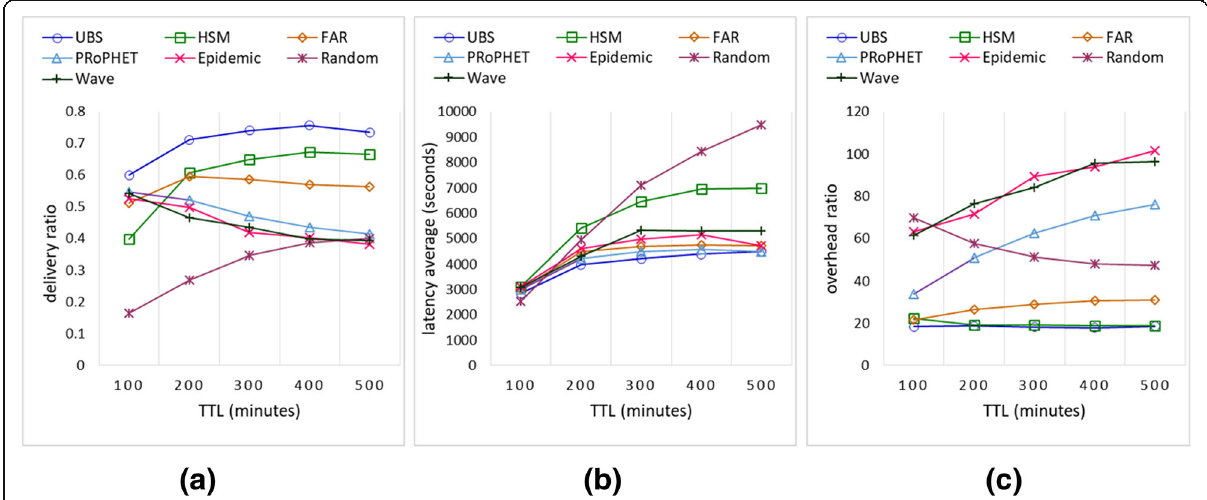
Fig. 12 The performance of schemes by varying message life